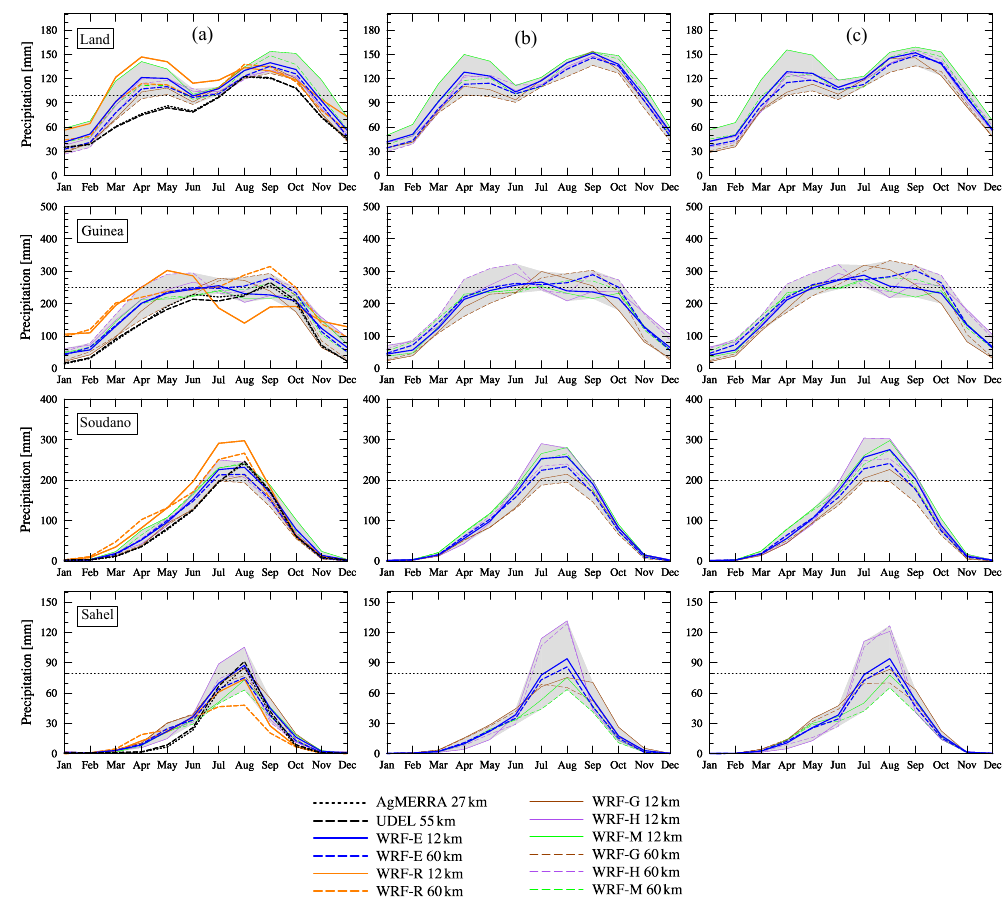
Figure 3. Annual cycle of precipitation for the historical period 1980–2010 (a) , the near future 2020–2050 (b) , and the end of the 21st century 2070–2100 (c) , averaged over all land area and for the different regions displayed in Fig. 1. WRF-R: ERA-Interim control run; WRF-M: MPI- ESM-MR historical run; WRF-H: HadGEM2-ES historical run; WRF-G: GFDL-ESM2M historical run; WRF-E: multi-model ensemble of WRF-M, WRF-H and WRF-E. The shaded areas encompass the entire spread of the 12 and 60km members of the multi-model